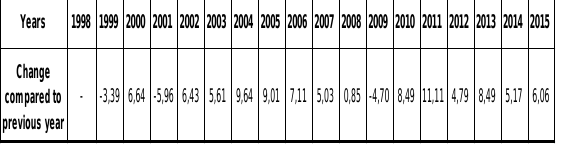
Source: TUİK Table 2: GDP changes for 1998-2015 (%)